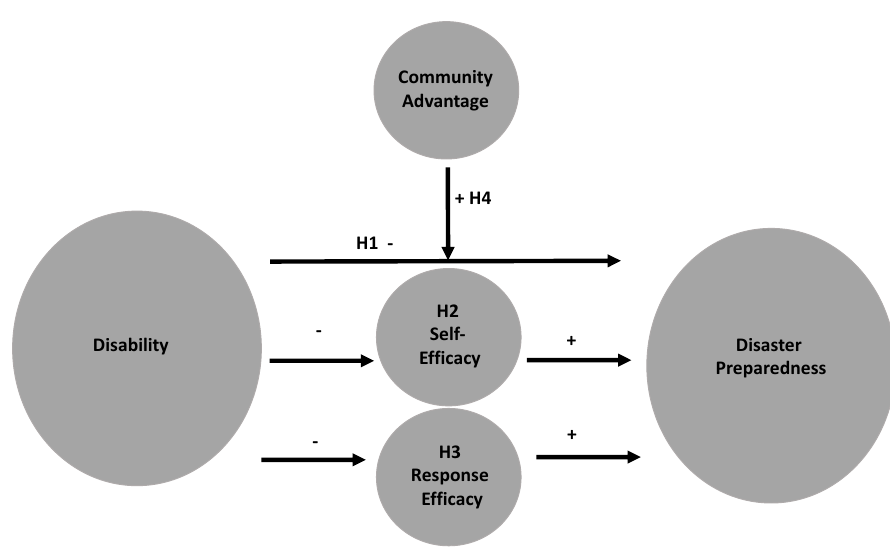
Figure 1. Conceptual model linking disability and disaster preparedness.